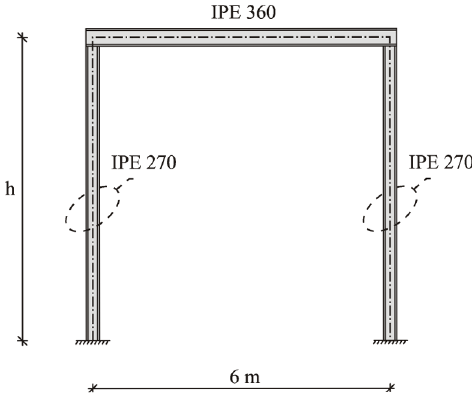
Fig. 1. Steel frame geometry